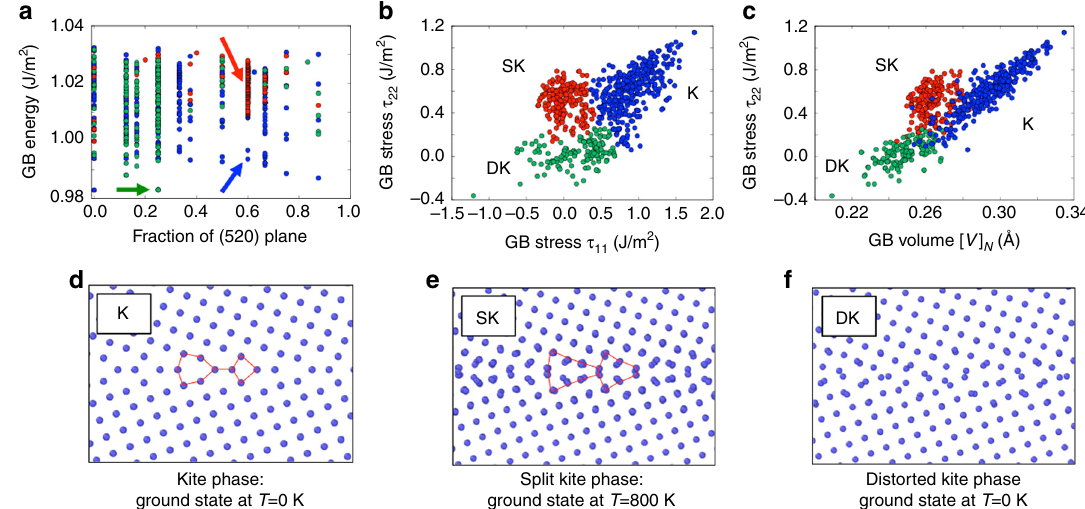
Fig. 7 Clustering identi fi es GB phases observed at high temperature. Metastable grain boundary phases identi fi ed by the clustering analysis at 0 K become stable at high temperature. Evolutionary search a and clustering b , c for the Σ 29(520) [001] predict three grain boundary phases: d Kites, e Split Kites, and f Distorted Kites. Kite phase is the ground state at 0 K. Split Kite phase is a high energy state at 0 K, but becomes a ground state with the lowest free energy at fi nite temperature, as demonstrated by a transformation in MD simulations at 900